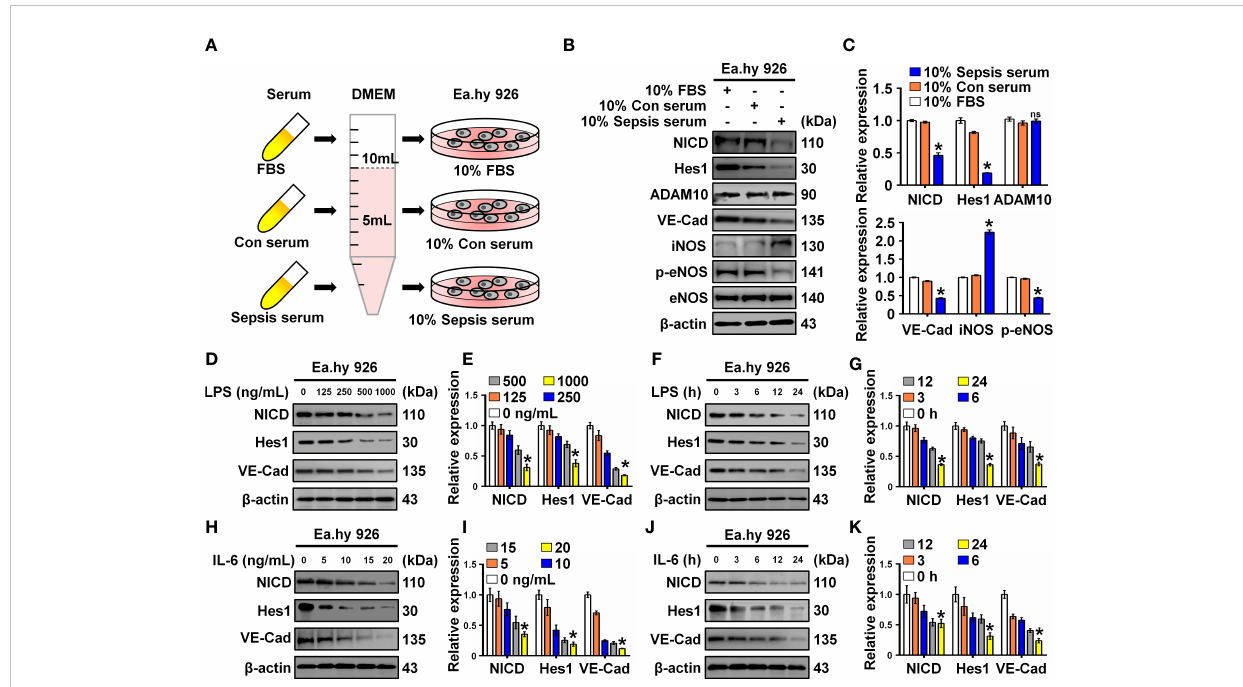
FIGURE 1 Serum from sepsis patients, LPS and IL-6 inhibit Notch signaling. (A) FBS, control, and sepsis serum were collected to treat Ea.hy 926 cells. (B, C) The expression of NICD, Hes1, ADAM10, VE-Cad, iNOS, p-eNOS, and eNOS in Ea.hy 926 cells were tested by Western blot after treating with the collected serum for 4 (h) Representative images (B) and three experiments replicates (C) were displayed. (D, E) The levels of NICD, Hes1 and VE-Cad were detected by Western blot in Ea.hy 926 cells stimulated with the indicating concentration of LPS for 24 (h) Representative images (D) and three experiments replicates (E) were displayed. (F, G) The expression of NICD, Hes1 and VE-Cad were detected by Western blot in Ea.hy 926 cells stimulated with 1000 ng/mL LPS for indicating time. Representative images (F) and three experiments replicates (G) were displayed. (H, I) The expression of NICD, Hes1 and VE-Cad were quanti fi ed by Western blot in Ea.hy 926 cells stimulated with the indicating concentration of IL-6 for 24 (h) Representative images (H) and three experiments replicates (I) were displayed. (J, K) The levels of NICD, Hes1 and VE-Cad were quanti fi ed by Western blot in Ea.hy 926 cells stimulated with 20 ng/ml IL-6 for indicating time. Representative images (J) and three experiments replicates (K) were displayed. Data are shown as the mean ± SEM. ns, no signi fi cance; * p <